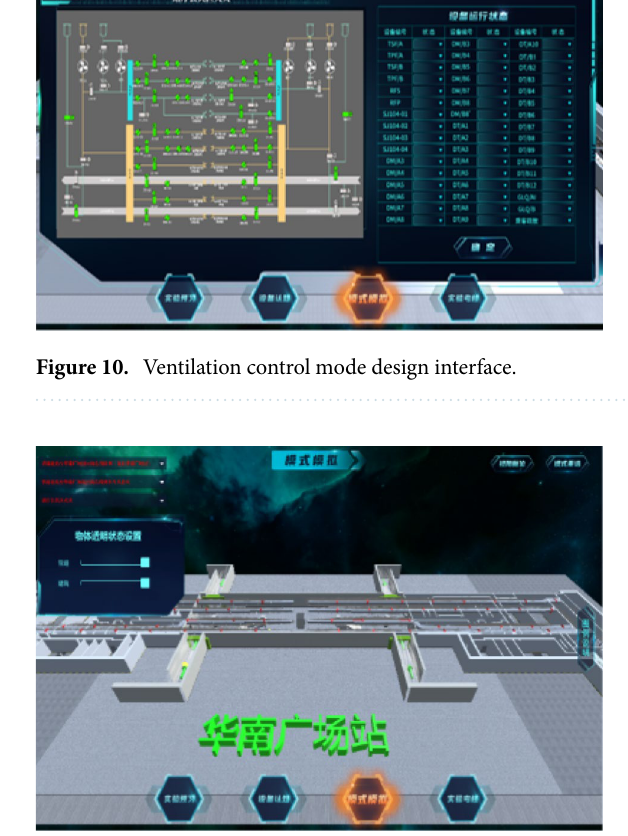
Figure 11. Ventilation system route.